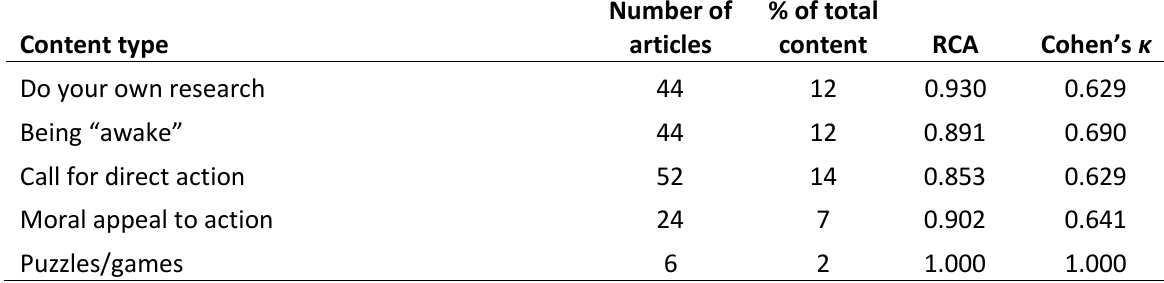
Table 2. Participatory content in The Light (all